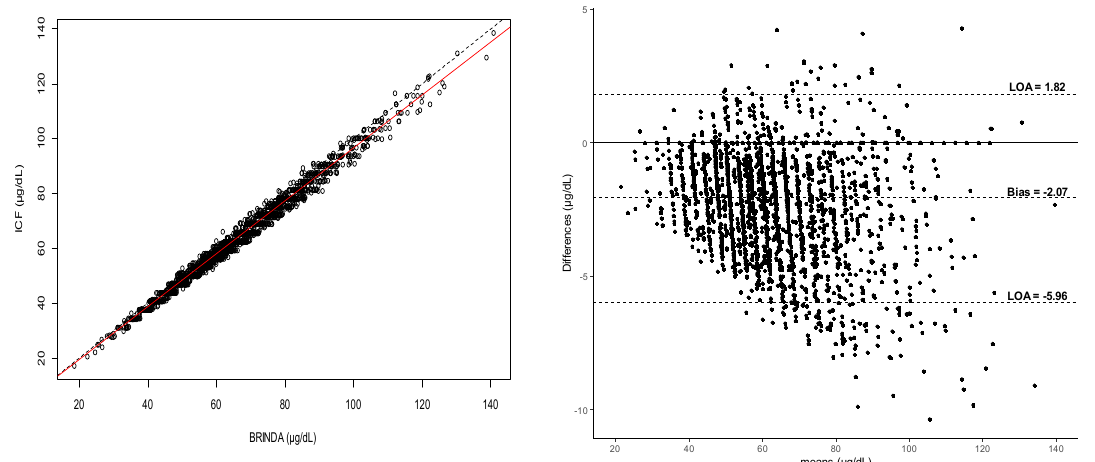
Figure 2. Method comparisons between ICF and BRINDA approaches, presented as a linear correlation in the left panel and Bland–Altman plot in the right panel.